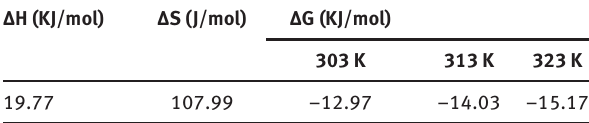
Table 7: Activation energy and thermodynamic